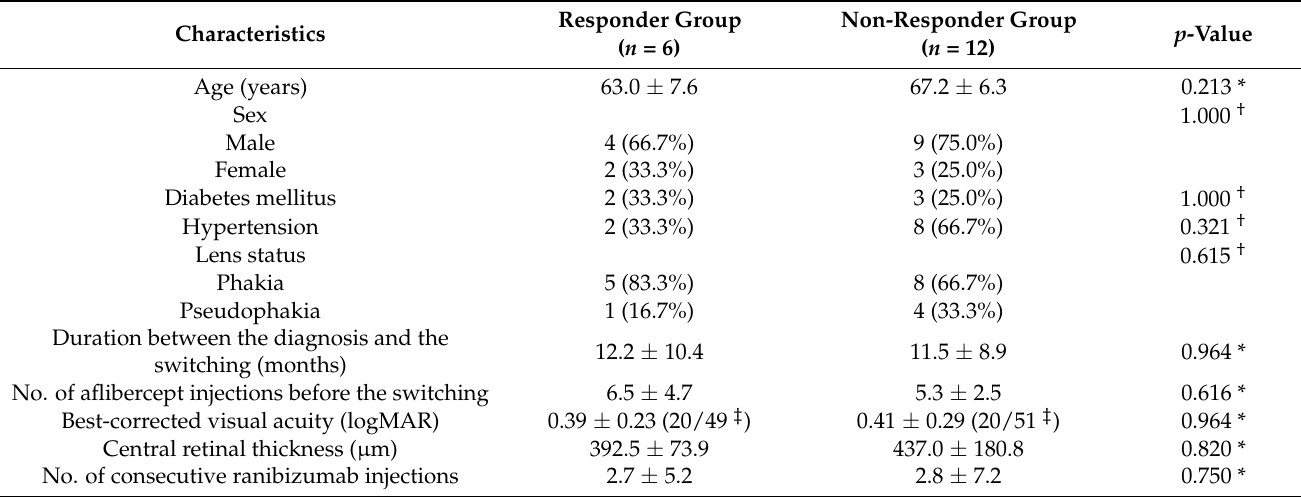
Table 3. Comparison of the characteristics of the responder group and the non-responder group in patients with aflibercept- resistant polypoidal choroidal vasculopathy after switching from aflibercept to ranibizumab treatment.